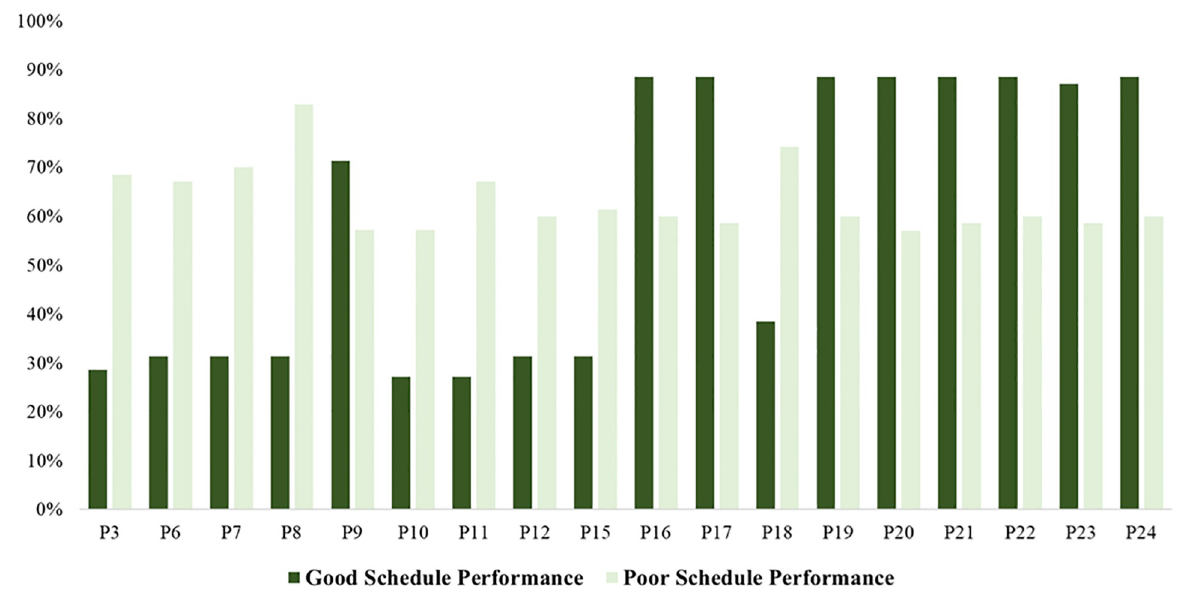
Fig 5. Comparison of scores of reconstruction schedule performance predictors- Likert-scale